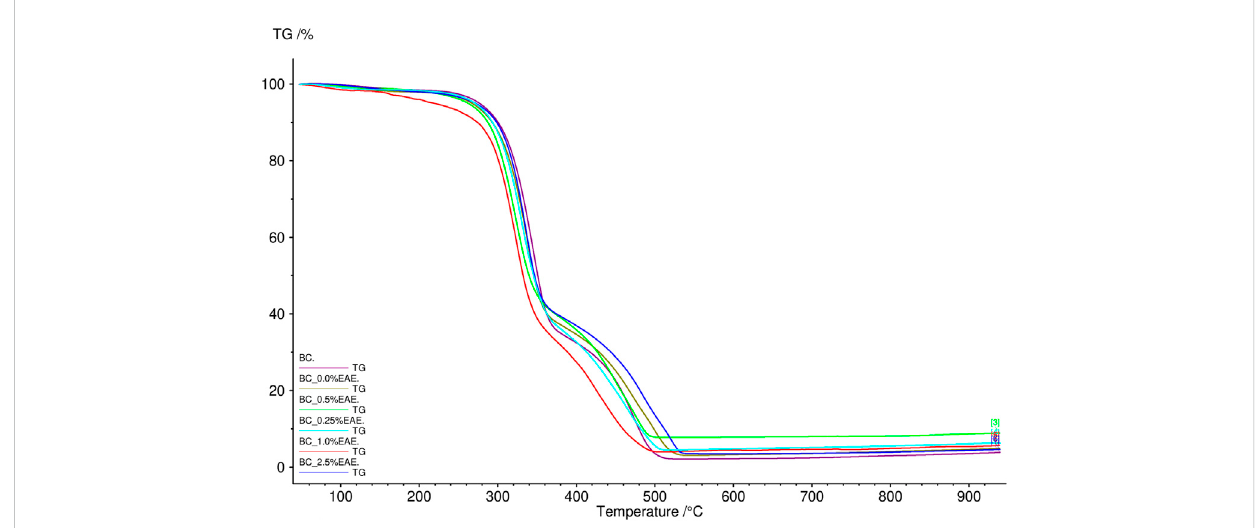
FIGURE 2 TG curves of bacterial cellulose — BC (violet), BC-0.25%EAE (light blue), BC-0.5%EAE (green), BC-1%EAE (red), and BC-2.5%EAE (dark blue).